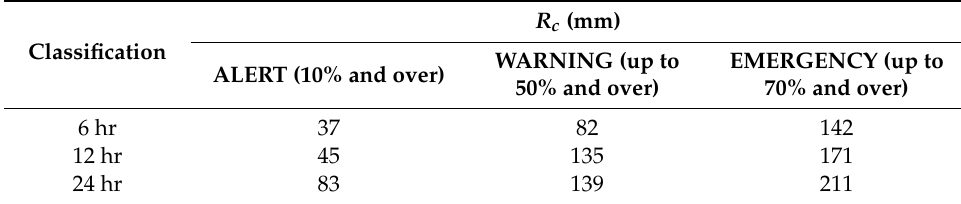
Table 5. Estimation of critical accumulated rainfall ( R c